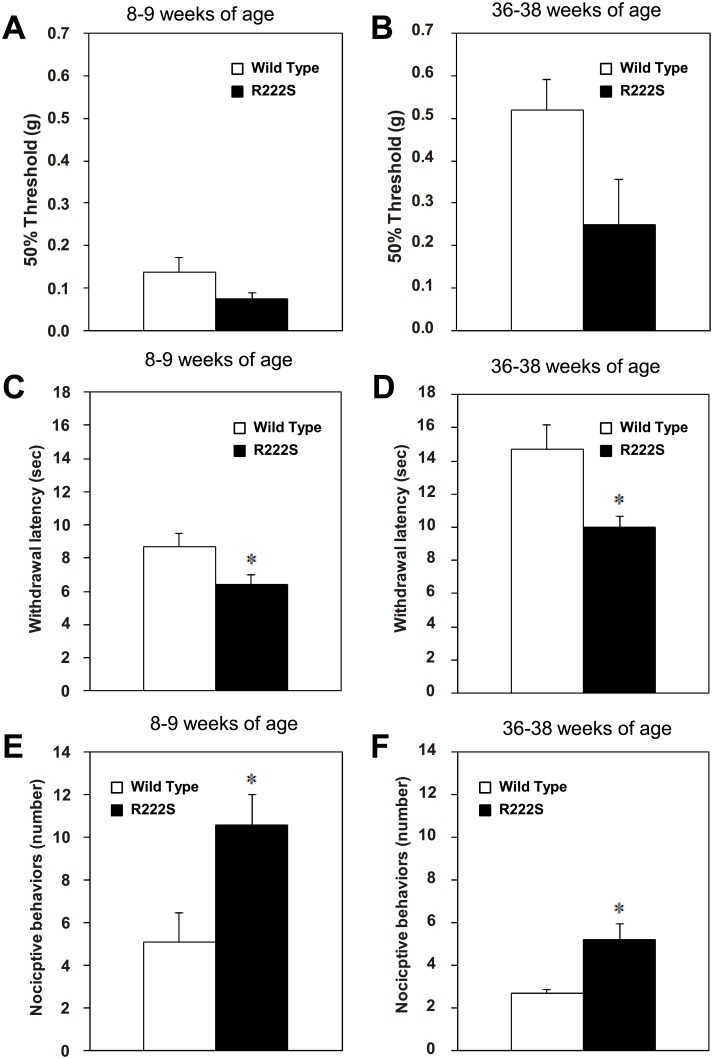
Behavioral phenotype comparison between R222S and WT mice.Sensitivity to a mechanical stimulus (determined by measuring the 50% threshold in the von Frey test) in 8–9-week-old mice (A) and 36–38-week-old mice (B); to a thermal stimulus (determined by measuring paw withdrawal latency in the Hargreaves test) in 8–9-week-old mice (C) and 36–38-week-old mice (D); to a cold stimulus (determined by measuring the number of nociceptive behaviors in the cold plate test) in 8–9-week-old mice (E) and 36–38-week-old mice (F). Open and closed columns show WT (8–9 weeks old, n = 10; 36–38 weeks old, n = 6) and R222S mice (8–9 weeks old, n = 12; 36–38 weeks old, n = 5), respectively. Data are presented as mean and S.E.M. (*p < 0.05; two-sided Student’s t test).